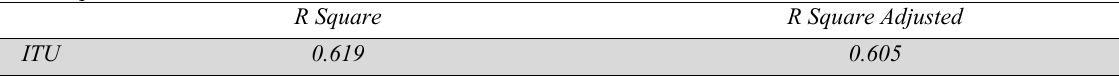
Nilai R Square R Square R Square